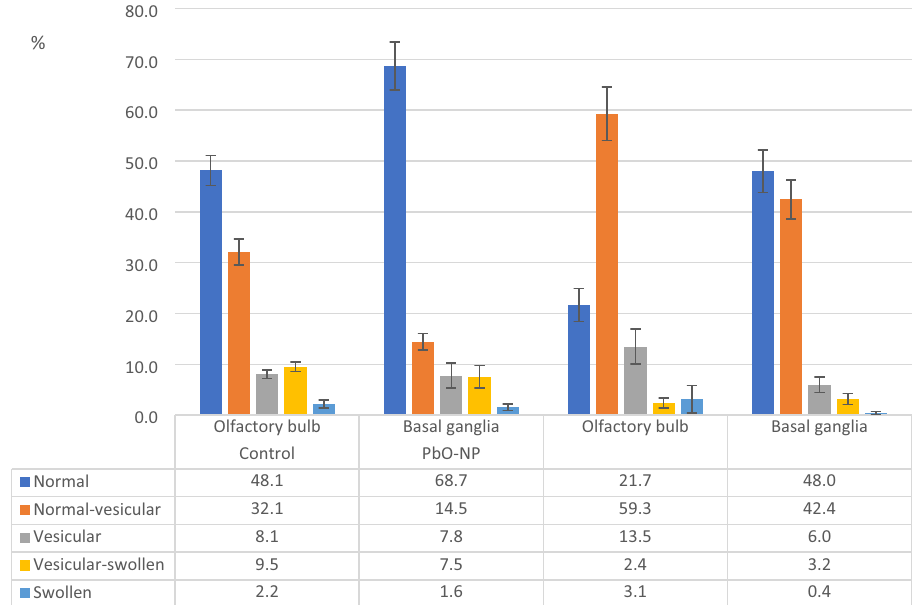
Figure 6. Neuronal mitochondrial ultrastructure damages in the control group and PbO NP exposure groups by brain regions. Notes: Values are given as the arithmetic mean of the fraction of mitochondria in the total number of neuronal mitochondria found; whiskers show the standard error of the mean.